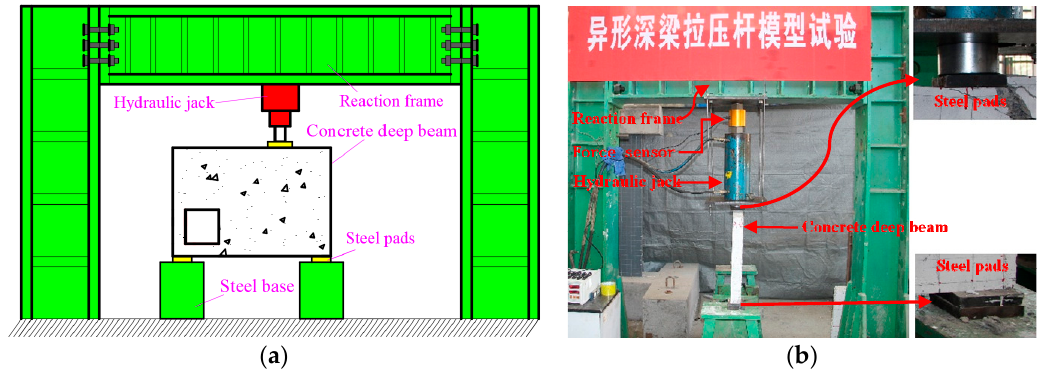
Figure 14. Diagrams of ( a ) test loading and ( b ) actual specimen installation.